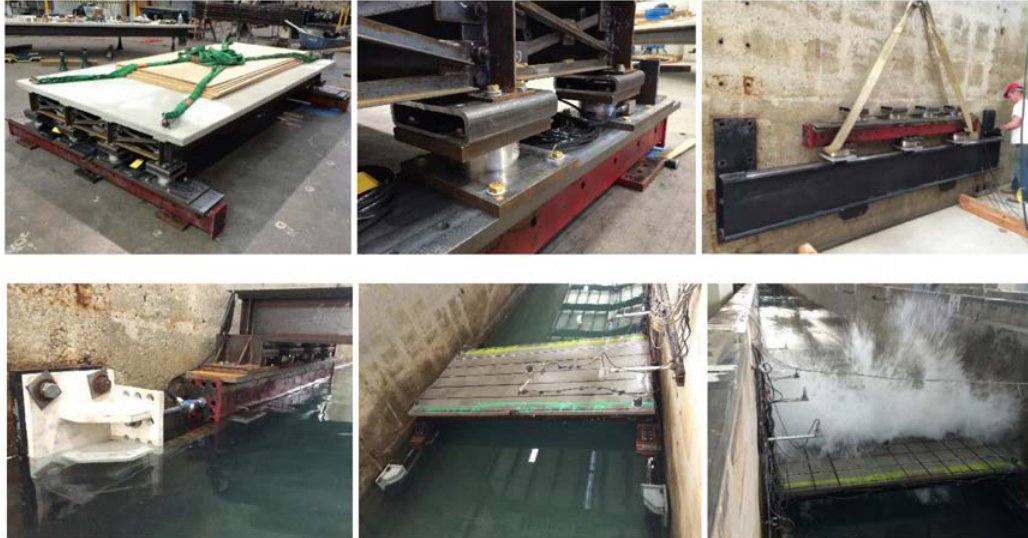
Figure 3. Test specimen and components during the pre-test assembly in the Large-Scale Structures Laboratory at the University of Nevada, Reno (UNR) and during the hydrodynamic testing phase in the LWF at Oregon State University.